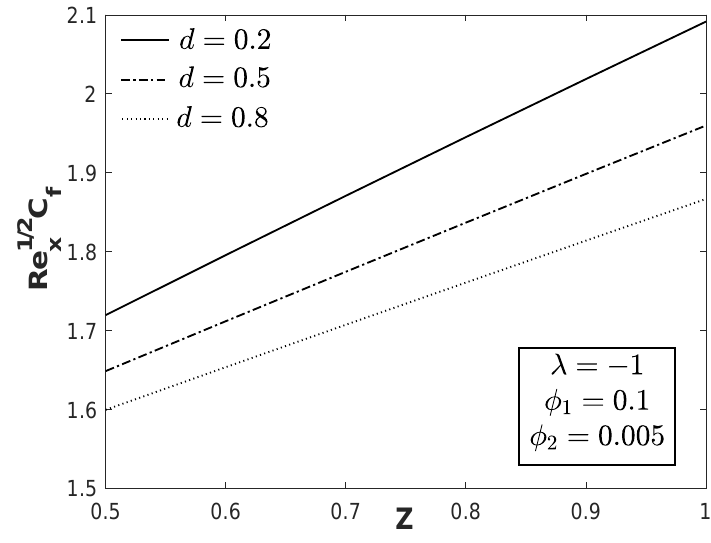
Figure 7. Re x 1/2 C f towards Z with various d